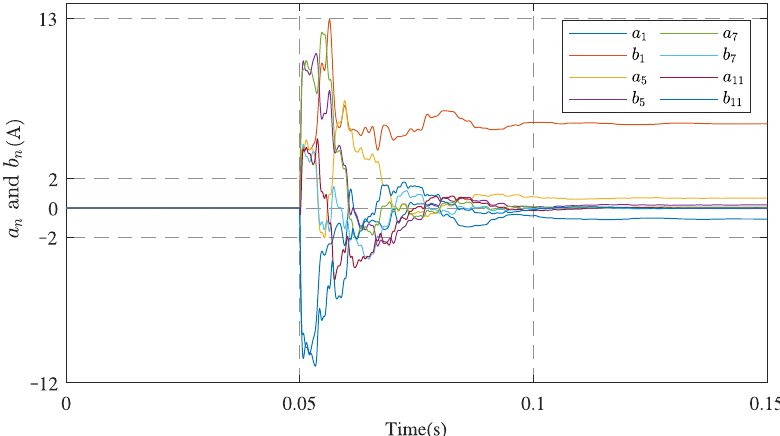
Figure 6. The stable convergence process of each harmonic parameter extraction.